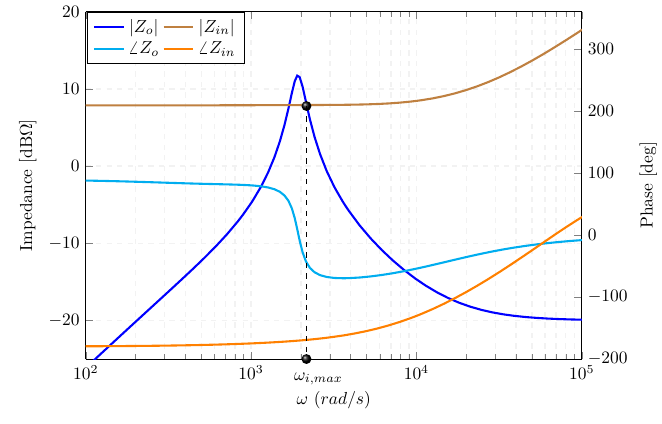
Figure 2. Typical source and load impedances of Figure 1, highlighting their interaction around ω i , max